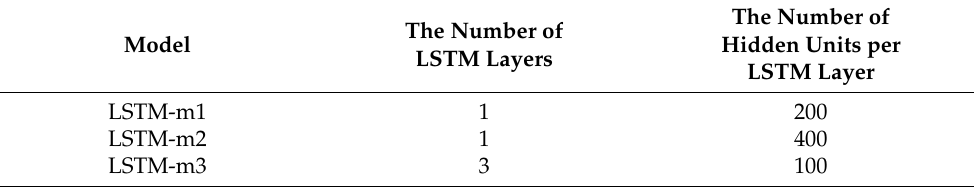
Table 5. LSTM layer and hidden unit settings for the LSTM-based anomaly detection models.